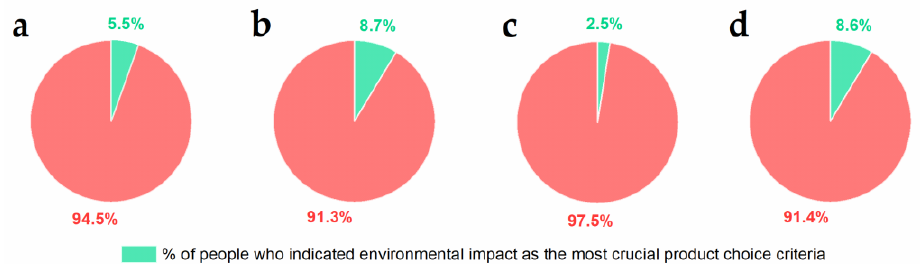
Figure 5. Percentage of people who indicated environmental impact as the most crucial criterion out of the four (technical parameters, application parameters, price, environmental impact) when choosing a construction product in the individual surveyed groups: ( a ) investors, ( b ) architects, ( c ) contractors, ( d ) sellers of construction products.